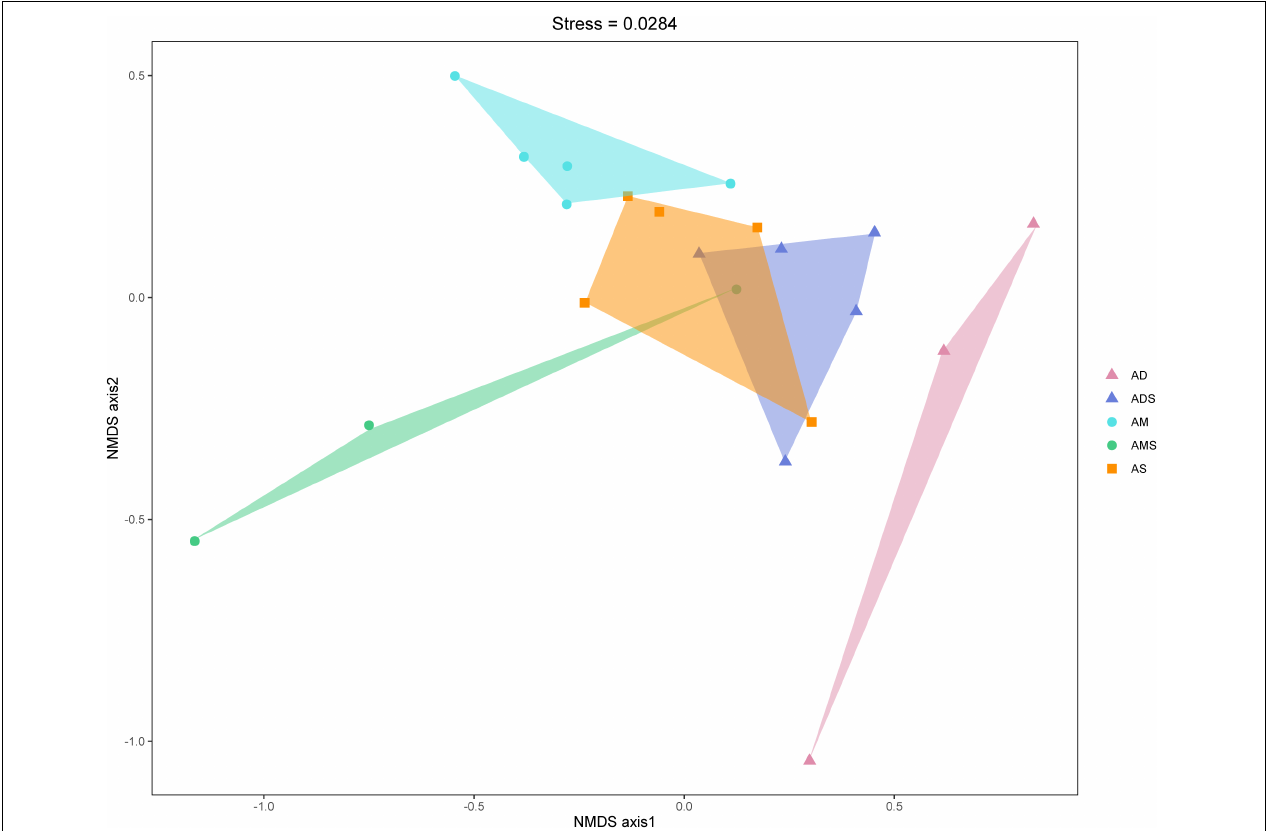
FIGURE 5 | Non-metric multidimensional scaling (NMDS) analysis of the soil bacteria in alpine grasslands on the Tibetan Plateau. Different shaped dots represent the samples from different alpine grassland types, and the bumps of the samples bound the faces of different colors. AD, alpine desert; ADS, alpine desert steppe; AM, alpine meadow; AMS, alpine meadow steppe; AS, alpine